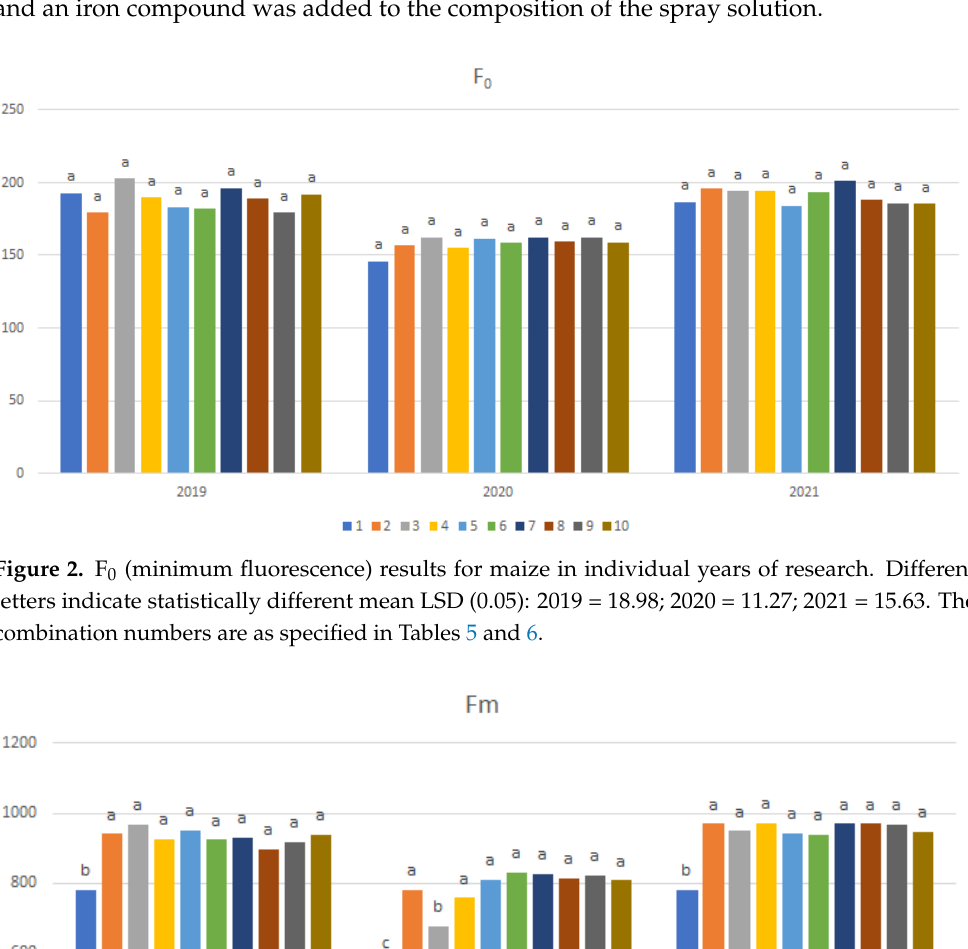
Figure 4. Fv (variable fluorescence) results for maize in individual years of research. Different let- ters indicate statistically different mean LSD (0.05): 2019 = 79.59; 2020 = 58.64; 2021 = 93.13. The combination numbers are as specified in Tables 5 and 6.